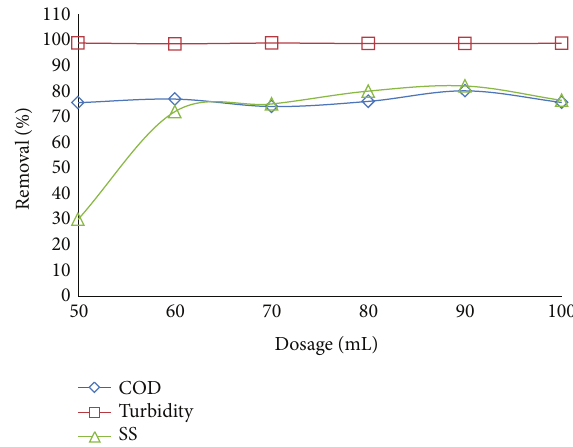
Figure 4: Effect of banana stem juice dosage on the coagulation process of spent coolant wastewater. Table 4: Compliance of treated spent coolant wastewater using banana stem juice with Malaysian standard effluent discharge limit.